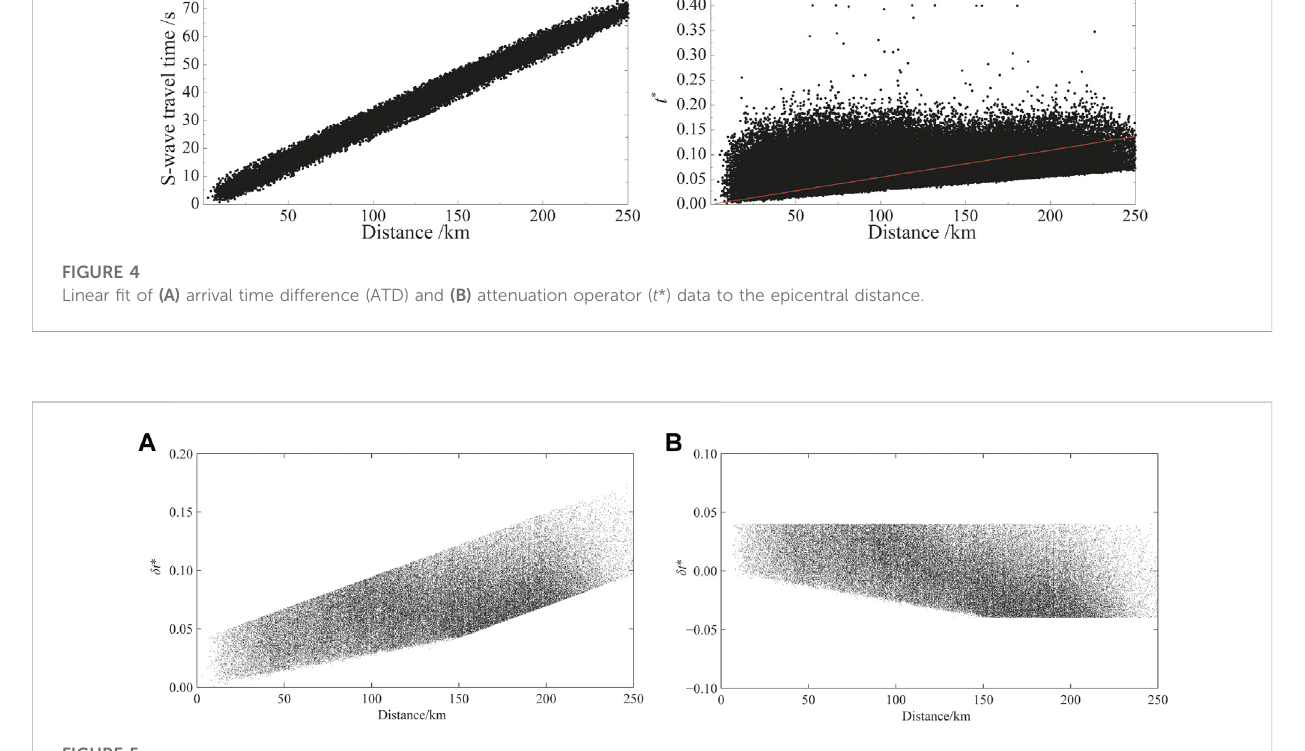
FIGURE 5 Variation in the residual with epicentral distance, (A) before and (B) after